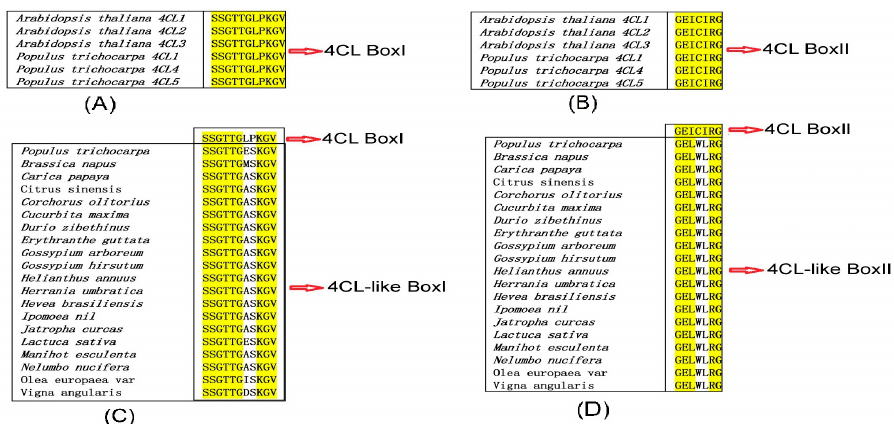
Figure 2. Comparison of the conserved regions of the box I and box II domains. ( A ) Comparison of the conserved regions of the box I domain among At4CL1 (NP_001077697.1), At4CL2 (AF_106086.1), At4CL3 (AF_106087.1), Pt4CL1 (XP_002297699.2), Pt4CL4 (XP_002324477.2), and Pt4CL5 (XP_002304825.2). ( B ) Comparison of the conserved regions of the box II domain among At4CL1, At4CL2, At4CL3, Pt4CL1, Pt4CL4, and Pt4CL5. ( C ) Comparison of the conserved regions of